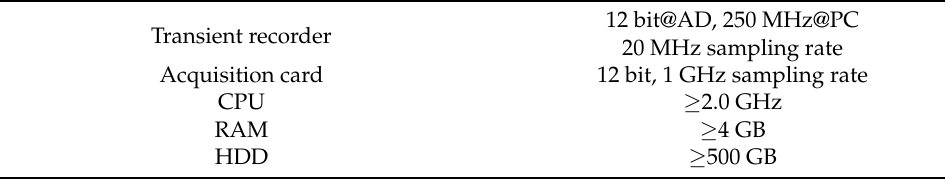
Table 3. Control and acquisition